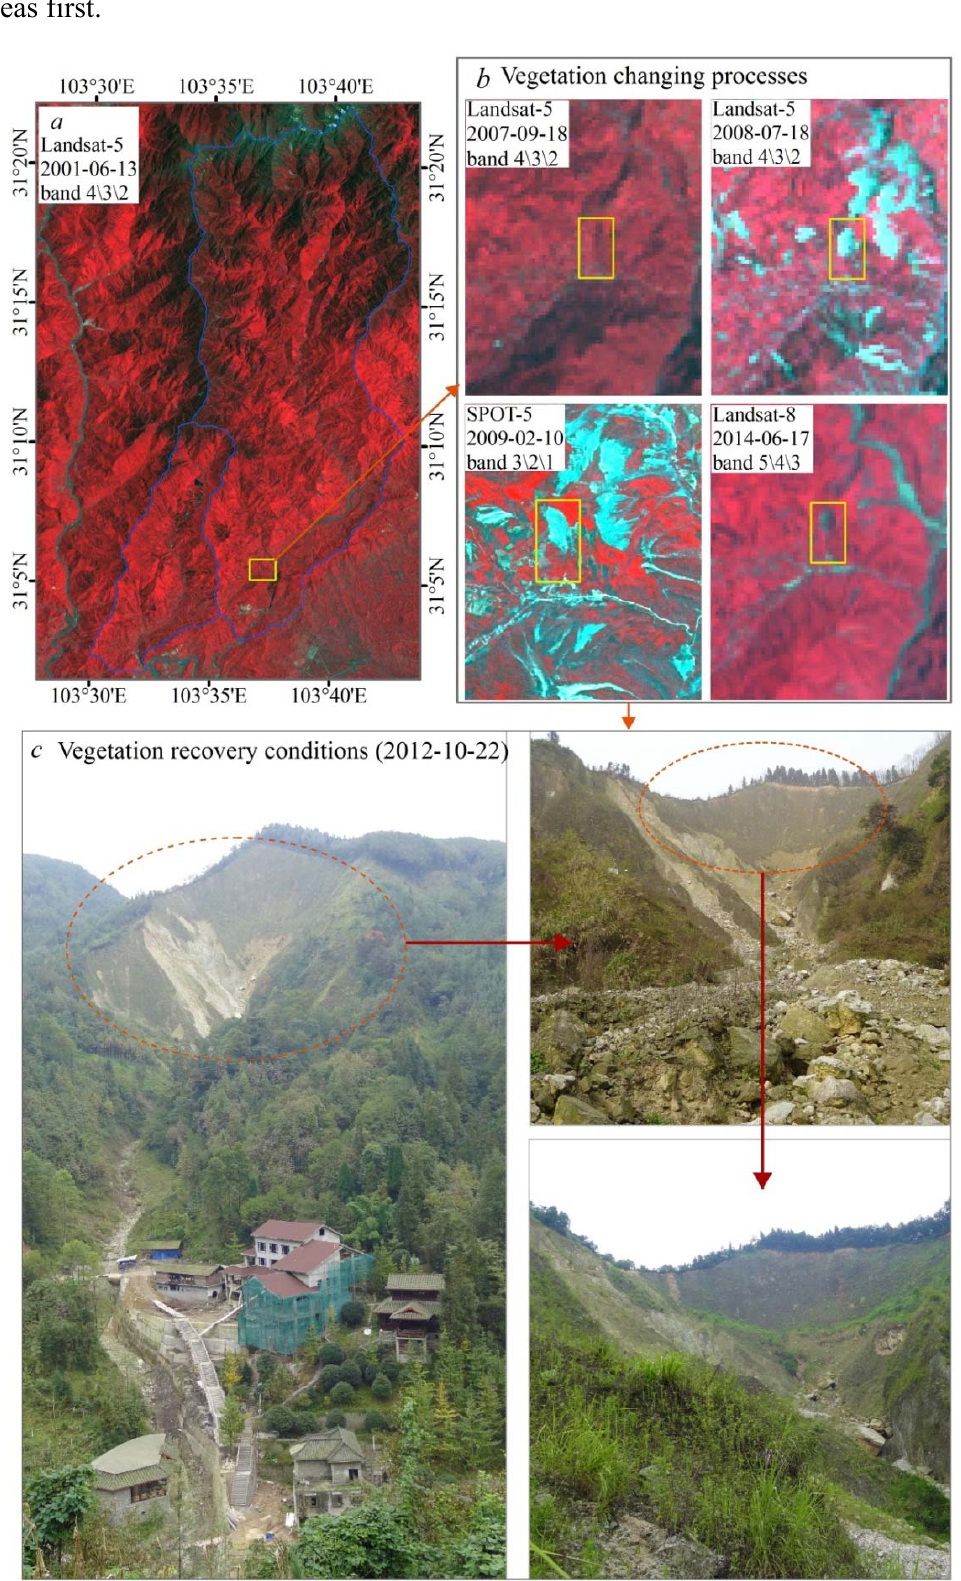
Figure 3. Pre- and post-earthquake vegetation in the Guoquanyan gully: ( a ) Guoquanyan gully location; ( b ) vegetation changing processes; ( c ) vegetation recovery